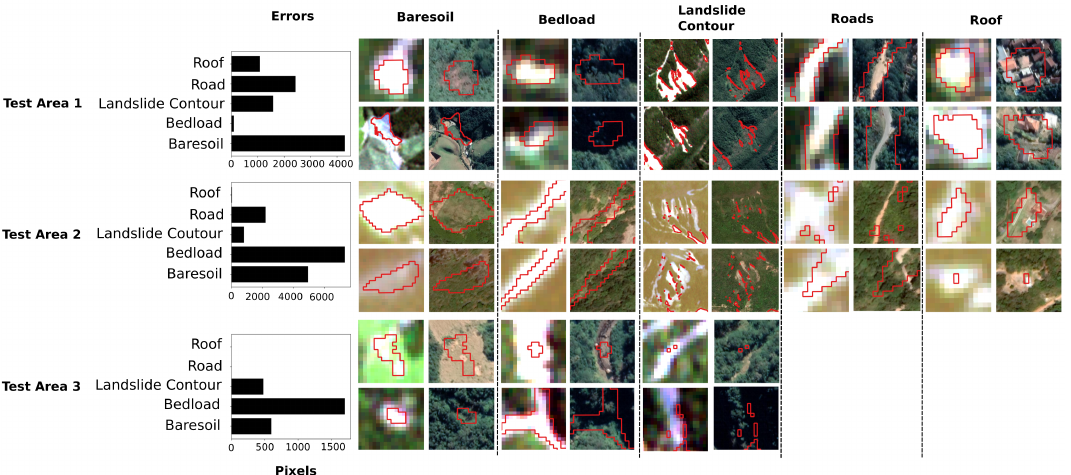
Figure 8. Comparison of the most frequent errors made by the deep learning models during landslide segmentation and histograms showing the number of pixels for each error category. Images with lower resolution ( left ) are from the RapidEye satellite, and images with higher resolution ( right ) are from Google